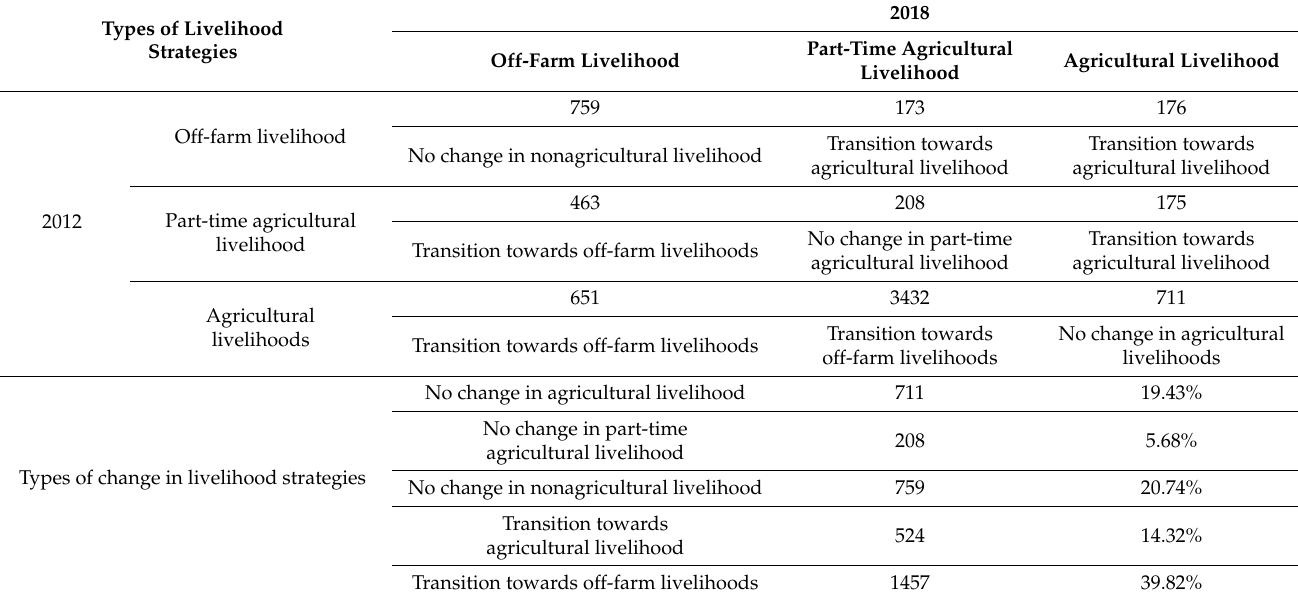
Table 4. Types and statistical description of changes in household livelihood